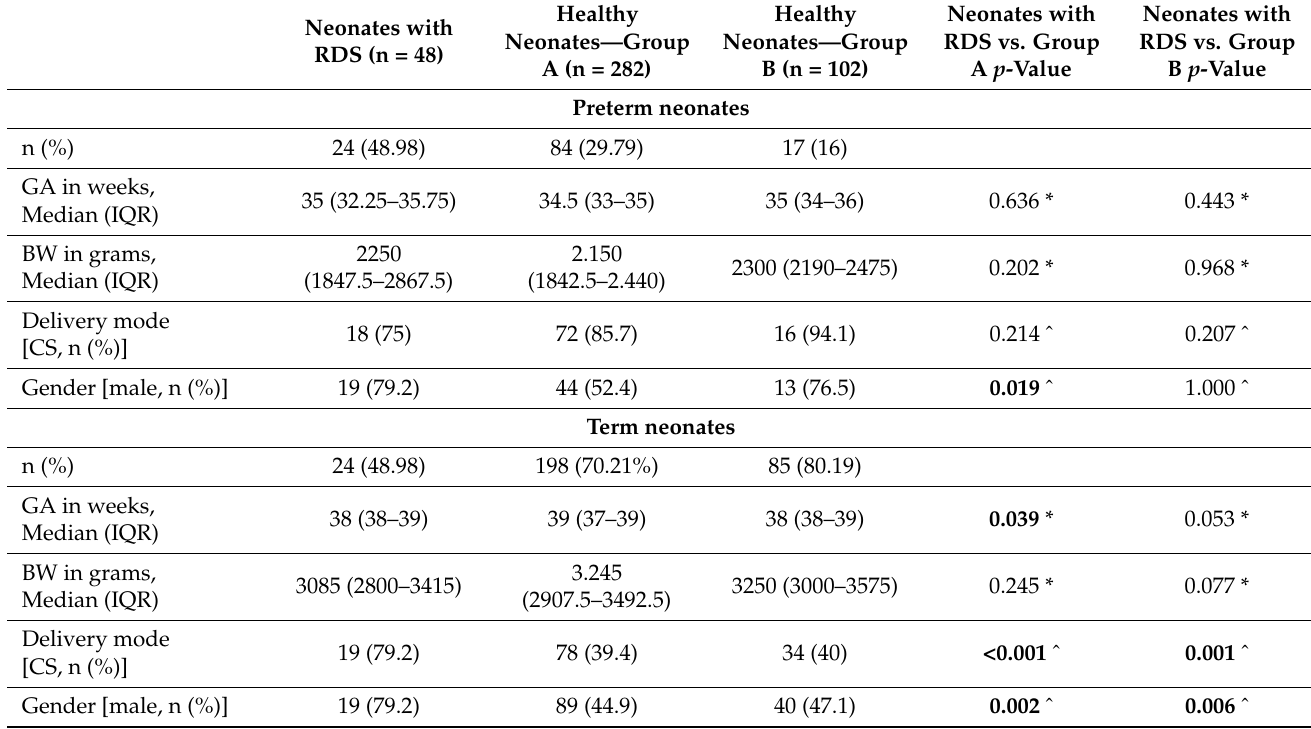
Table 1. General characteristics of the neonates with RDS and the control groups.